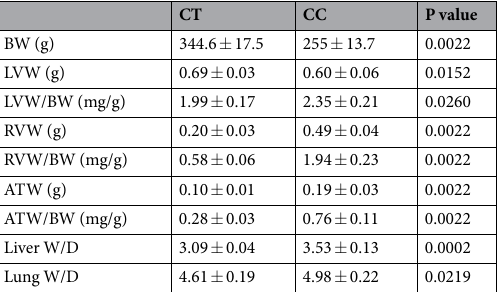
Table S1). Microarray data are available in Gene Expression Omnibus GSE72701, and the mRNA differentially expressed in CC are provided in the supplementary material. In most cases, a functional class was assigned to these 1,281 regulated genes using the Gene Set Enrichment Analysis (Supplementary Table S2). The top over- and under-expressed genes were selected and ranked by a combination of p-value < 0.05 and fold change ≥ 5, and are listed in Supplementary Tables S3 and S4, respectively.